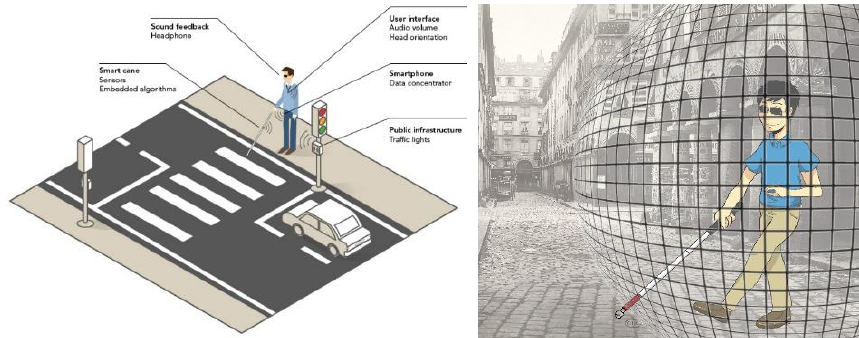
Figure 1. Left : primary demonstrator. Right : safety cocoon offered by the INSPEX system.